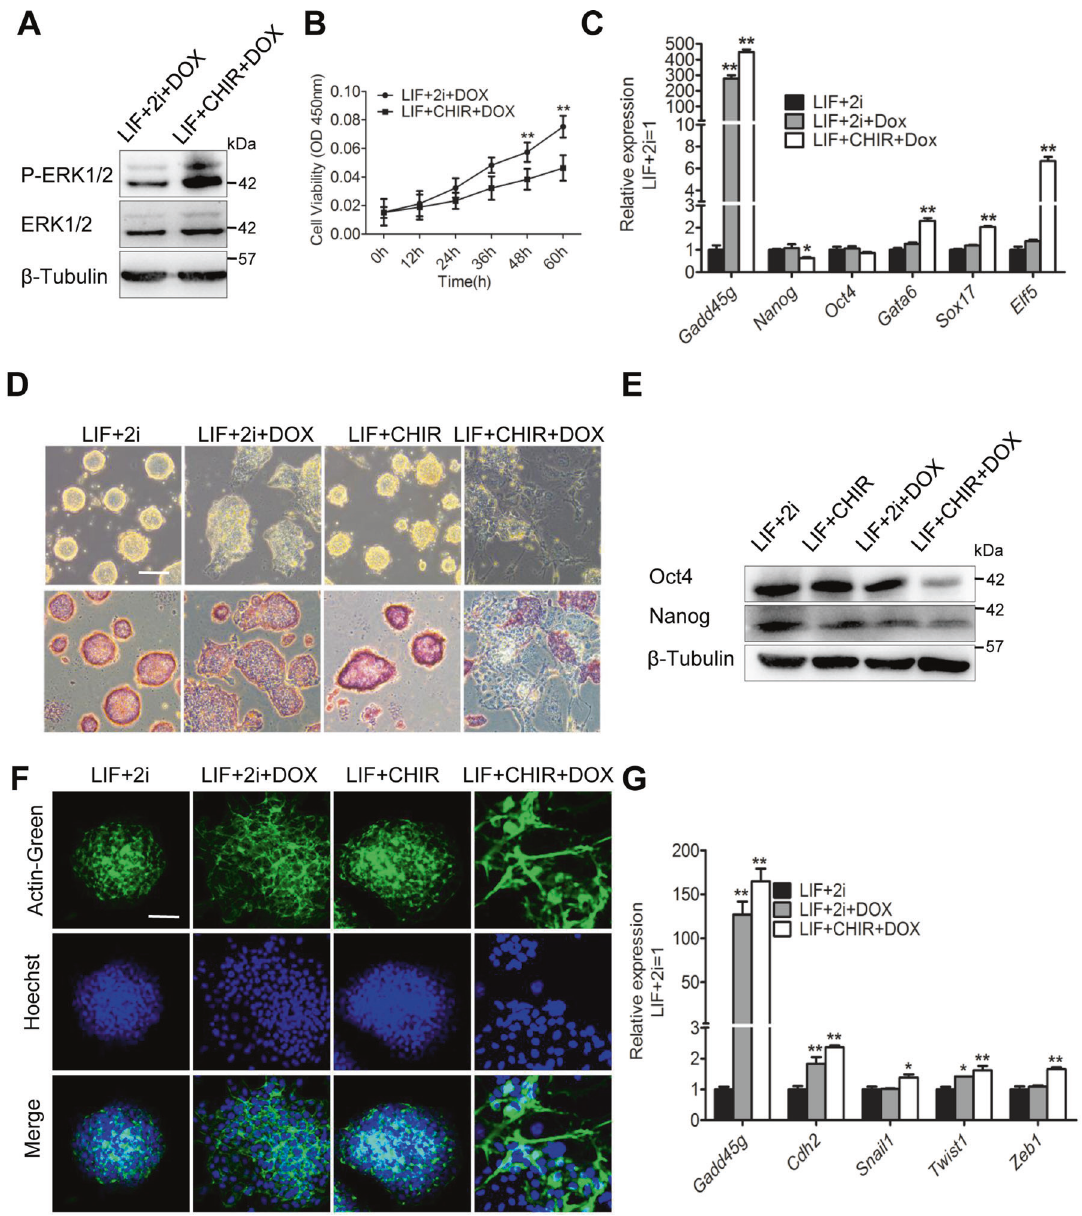
Fig. 4 Suppression of the MAPK signaling pathway inhibits differentiation caused by Gadd45g overexpression. A Western blot analysis of ERK1/2 and P-ERK1/2 levels in i-Gadd45g ESCs cultured in LIF/CHIR/Dox condition in the presence or absence of PD03. β -tubulin was used as a loading control. B The CCK8 assay was performed to analyze the proliferation of i-Gadd45g ESCs cultured in LIF/CHIR/Dox condition in the presence or absence of PD03. The data are represented as the means ± s.d. ( N = 3 independent biological experiments). ** p < 0.01 vs LIF + CHIR + Dox. C qRT-PCR analysis of Gadd45g, self-renewal (Oct4 and Nanog) and differentiation (Gata6, Sox17, and Elf5) gene expression levels in i-Gadd45g ESCs cultured in the indicated conditions. The data are represented as the means ± s.d. ( N = 3 biological replicates). * p < 0.05, ** p < 0.01 vs LIF + 2i. D Morphology and alkaline phosphatase (AP) staining of i-Gadd45g ESCs cultured in the indicated conditions. Bar, 100 μ M. E Western blot analysis of Oct4 and Nanog protein levels in i-Gadd45g ESCs cultured in the indicated conditions. β -tubulin was used as a loading control. F Actin-Tracker Green-488 fl uorescent probe staining of i-Gadd45g ESCs cultured in the indicated conditions. Bar, 100 μ M. G qRT-PCR analysis of the expression levels of Gadd45g and EMT marker genes in i-Gadd45g ESCs cultured in the indicated conditions. The data are represented as the means ± s.d. ( N = 3 biological replicates). * p < 0.05, ** p < 0.01 vs LIF + 2i. Quantitative real-time PCR (qRT-PCR) method and normalized to mouse RPL19 expression. The primers used are According to the manufacturer ’ s protocol, the TRIzol Up Plus RNA Kit listed in Table S3. (R0027, Beyotime, China) was used to isolate total RNA from cells. cDNA was synthesized from 1 µg of total RNA with the Hifair III 1st Strand cDNA Immuno fl uorescence staining Synthesis SuperMix for qPCR (11141ES60, YEASEN, China). mRNA expres- The cells were fi xed in 4% paraformaldehyde for 30 min and then were sion levels were determined using the Hieff qPCR SYBR Green Master Mix washed twice with PBS. After incubated for 2 – 3 h in blocking buffer (11201ES08, YEASEN, China) in a PikoReal Real-Time PCR machine (Thermo containing 5% BSA and 0.2% Triton X-100, the cells were probed with the Scienti fi c, USA). The relative expression level was determined by the 2- Δ Cq Cell Death Discovery (2021)